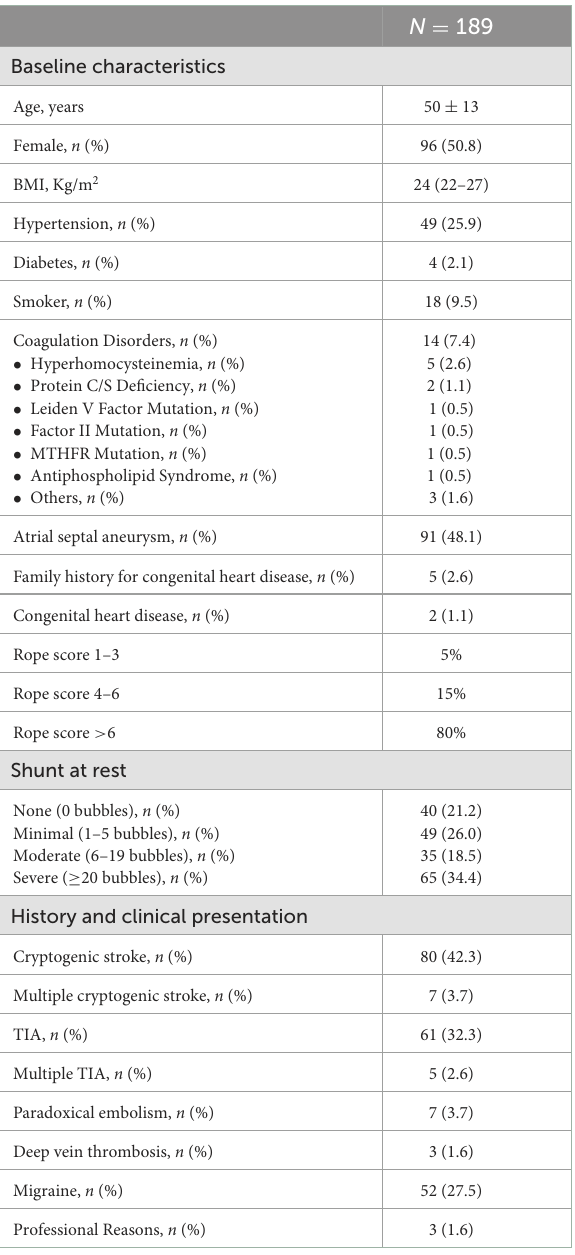
TABLE 1 Baseline demographic and clinical characteristics of the study population.